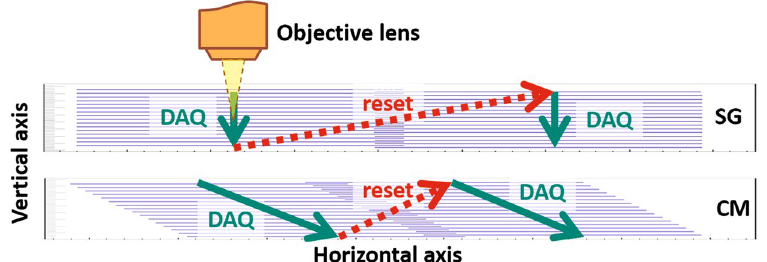
Figure 2. The schematic representation of the Stop&Go (SG) and the Continuous Motion (CM) scanning (hundreds of μ m), the longest movement is the horizontal one. As it is shown in the Fig. 2 (top scheme), during the DAQ phase of the SG (green solid arrow) the objective lens moves with a constant speed along the vertical axis only, producing a vertical image pile (blue thin horizontal lines), and then performs a long reset motion (red dotted arrow) to the next field of view. With wide fields of view and thin emulsions the reset motion takes even longer than the DAQ motion. In a certain sense the reset motion can be interpreted as a “dead time” of the